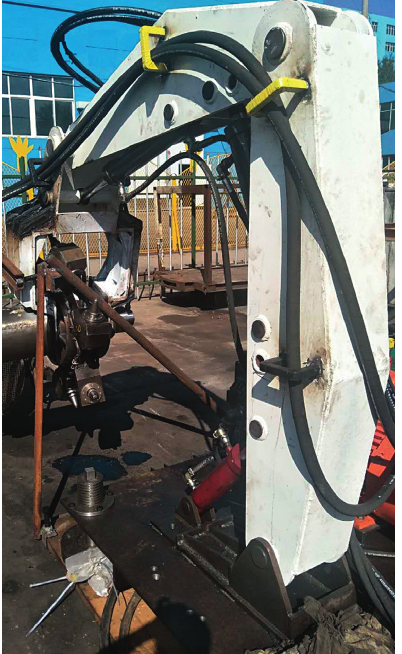
Figure 13: Ranging